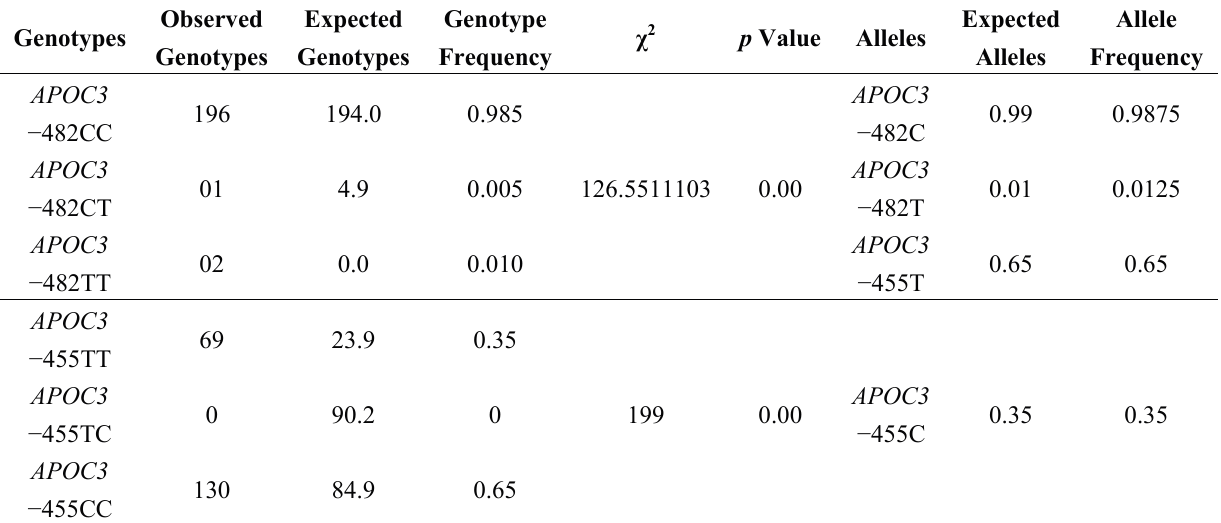
Table 2. Observed and expected allele and genotype frequencies of APOC3 promoter region in South African subjects determined by the Hardy-Weinberg method. Hardy-Weinberg Equilibrium is not applicable if there are less than five events in the genotypic analysis. χ 2 value indicates the difference between expected and observed genotype frequencies; Where p < 0.05 the expected and observed data are not consisted with